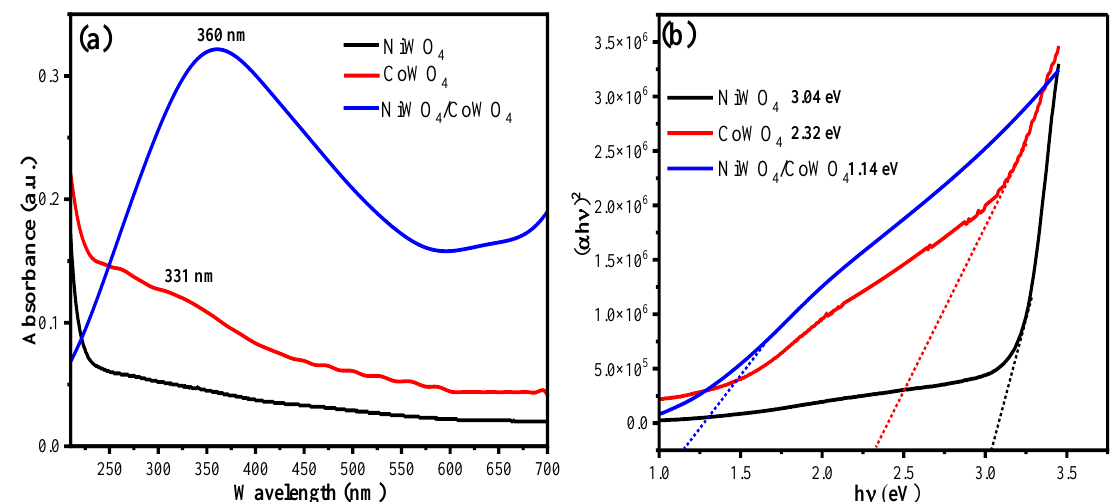
Figure 5. ( a ) UV–Vis plot of NiWO 4 , CoWO 4 , NiWO 4 /CoWO 4 NC in wavelength range of 200–700 nm; ( b ) Tauc ′ s plot for the band gap energy (E g ) of the materials. To further investigate the chemical oxidation state of the elements in the synthesized NiWO 4 /CoWO 4 NC material, XPS analysis was taken into consideration. Figure 6 (a) rep- resents the XPS survey spectra of NiWO 4 /CoWO 4 NC, which confirm the presence of W4f, O1s, Ni2p, and Co2p in the material. In order to observe the change in the oxidation states of elements during heterojunction formation, the deconvoluted spectres were studied. Figure 6 (b) represents the deconvoluted XPS spectra of W4f, which show two peaks at 46.48 eV and 49.49 eV, corresponding to the W4f 7/2 and W4f 5/2 states associated with W 6+ chemical state [29]. Figure 6 (c) represents three deconvoluted peaks for O1s, correspond- ing to 538.44, 539.44, and 541.44 eV, associated with O1 (Co–O), O2 (W–O), and O3 (Ni– O) bonds [30,31]. The XPS spectra in Figure 6 (d) for Co2P show two deconvoluted peaks at 868.01 and 872.78 eV associated with two states Co2p 3/2 and Co2p 1/2 states of Co 2+ , re- spectively [32]. Similarly, Figure 6 (e), corresponding to the XPS spectra of Ni2p, repre- sents the two states Ni2p 3/2 and Ni2p 1/2 for the Ni 2+ chemical state at 884.94 eV and 890.87 eV [33]. The outcomes of the XPS studies clearly confirm the formation of heterojunction NiWO 4 /CoWO 4 NC by the validation of the chemical stability of the Ni 2+ and Co 2+ ions in the lattice.